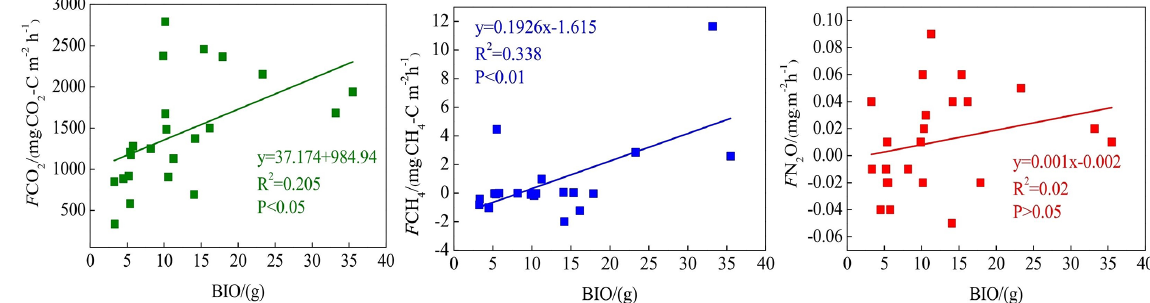
Figure 7. Correlation between aboveground biomass (BIO) and GHG emission ( F